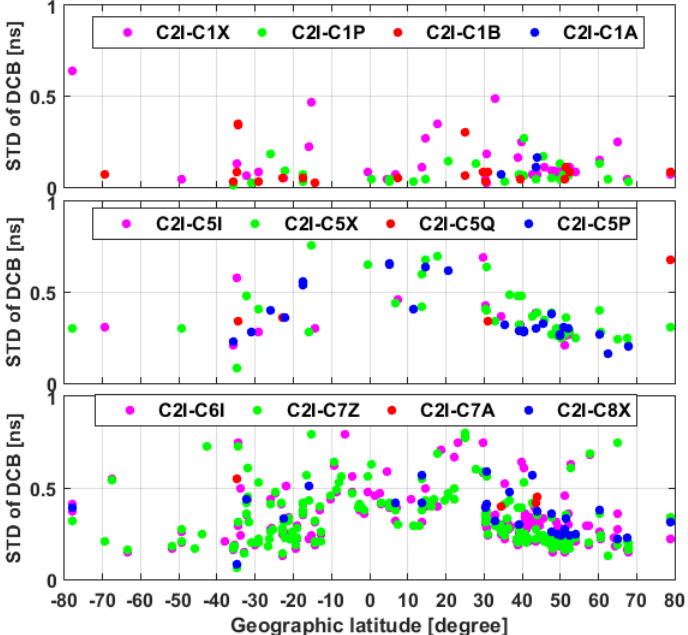
Figure 16. Scatterplots of the STDs of BDS3 receiver DCB estimates versus geographic latitudes.